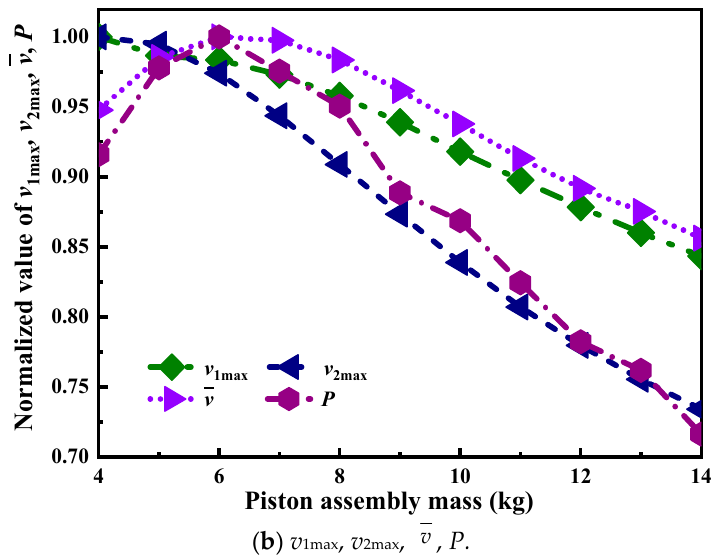
Figure 5. Variation of performance parameters with piston assembly mass.